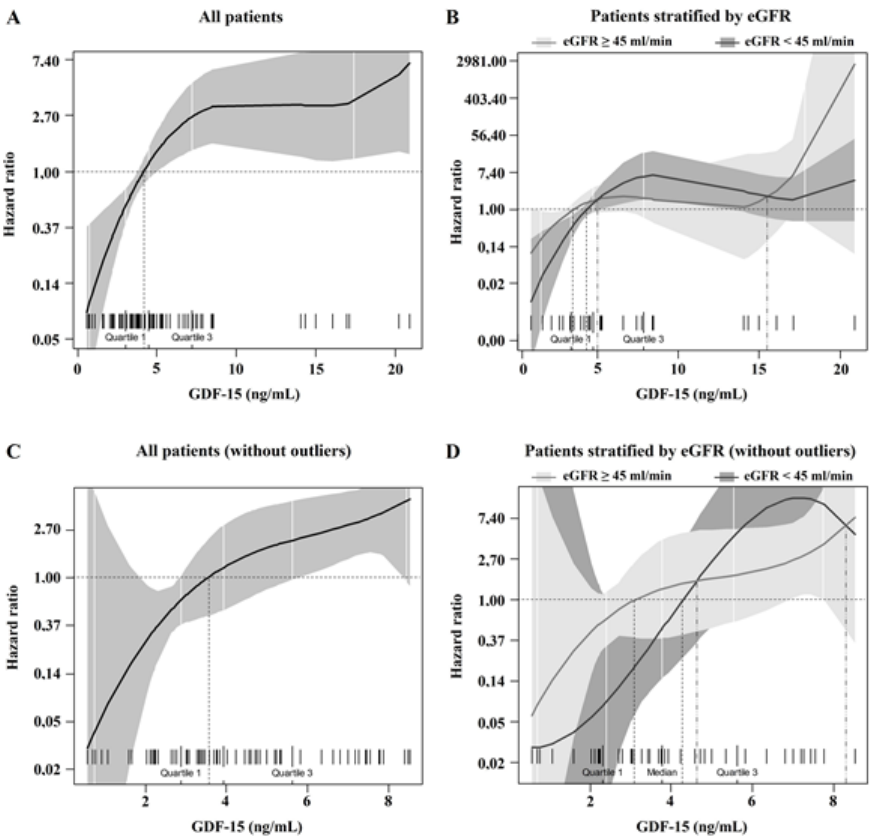
Figure 4. Non-linear association between continuous GDF-15 and mortality risk, adjusted for eGFR, age, fever, dyspnea and P/F. The solid line represents HR according to GDF-15 level. The colored area represents 95% CI, ticks in the lower part of the figure represent each observation. ( A ) All pa- tients of the whole study cohort. ( B ) Patients stratified according to eGFR strata. ( C ) All patients, excluding outliers for GDF-15. ( D ) Patients stratified by eGFR, excluding outliers for GDF-15.